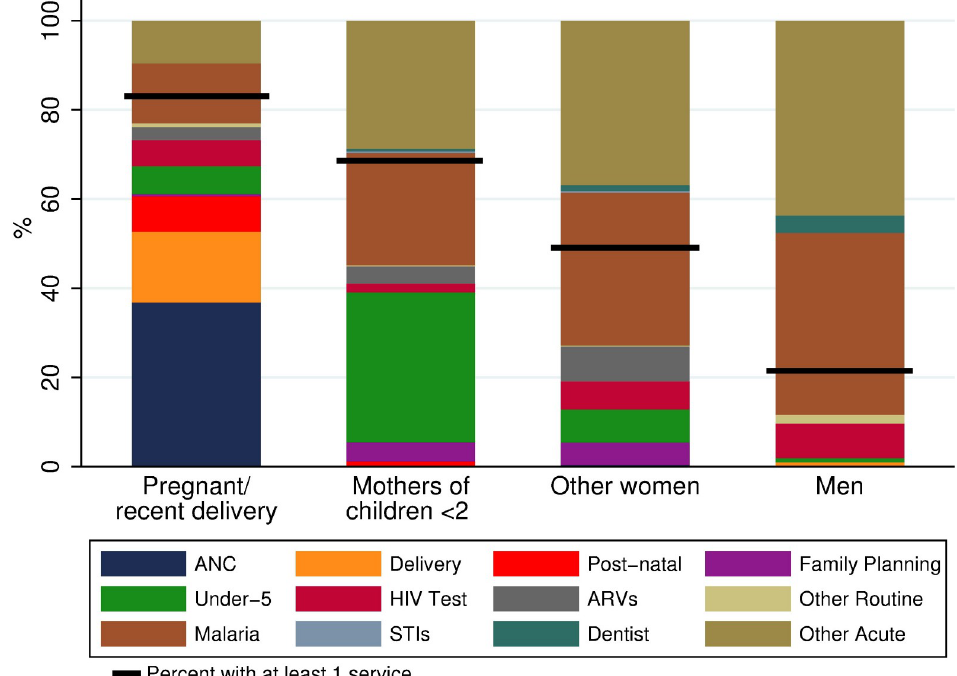
Fig 1. Main service types by subpopulation. Calculated as the percent of all services used by a subpopulation in a 2-month period.